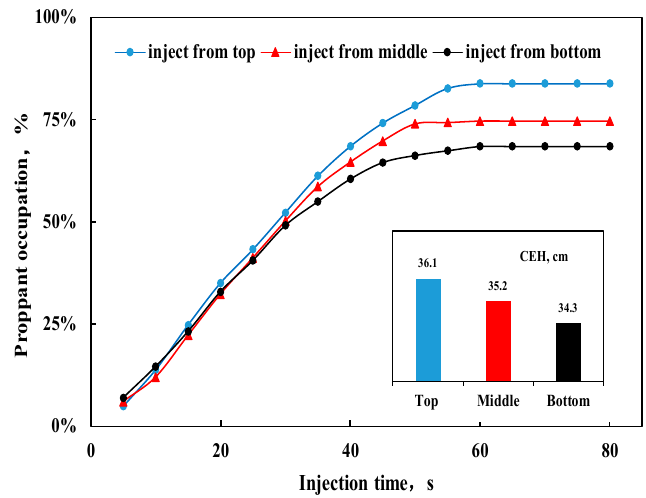
Figure 12. The curve for proppant occupation percentage in fracture change with time and CEH for different inlet position cases.